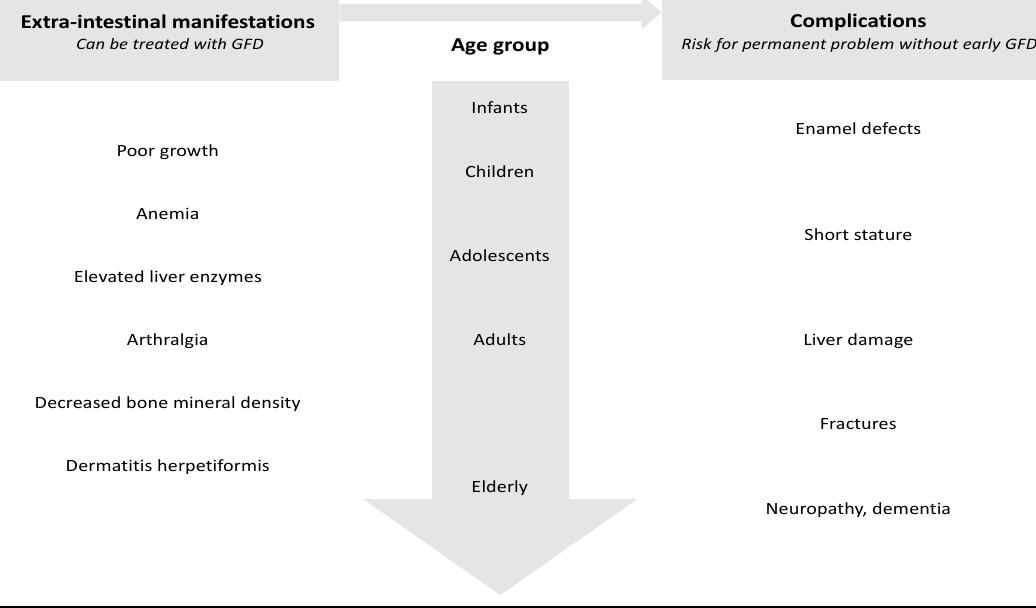
Figure 1. Extra-intestinal manifestations and complications of celiac disease classified based on their response to early initiated gluten-free diet (GFD) and typical age of development.